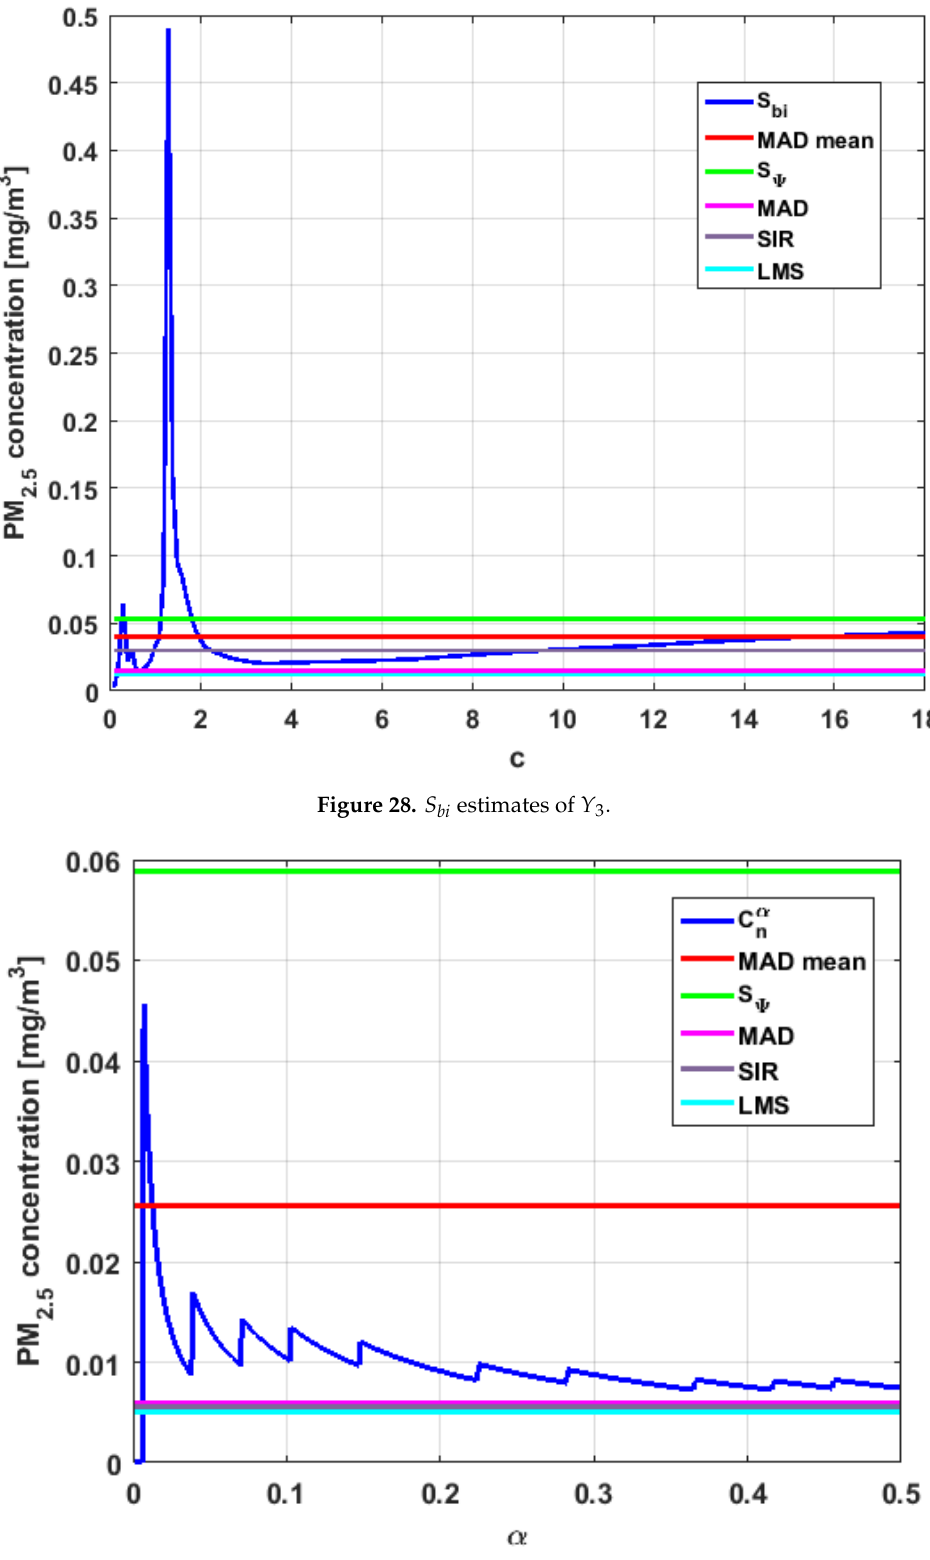
Figure 29. C α n estimates of X 1 Figure 29. 𝐶 𝑛𝛼 estimates of 𝑋 1 .